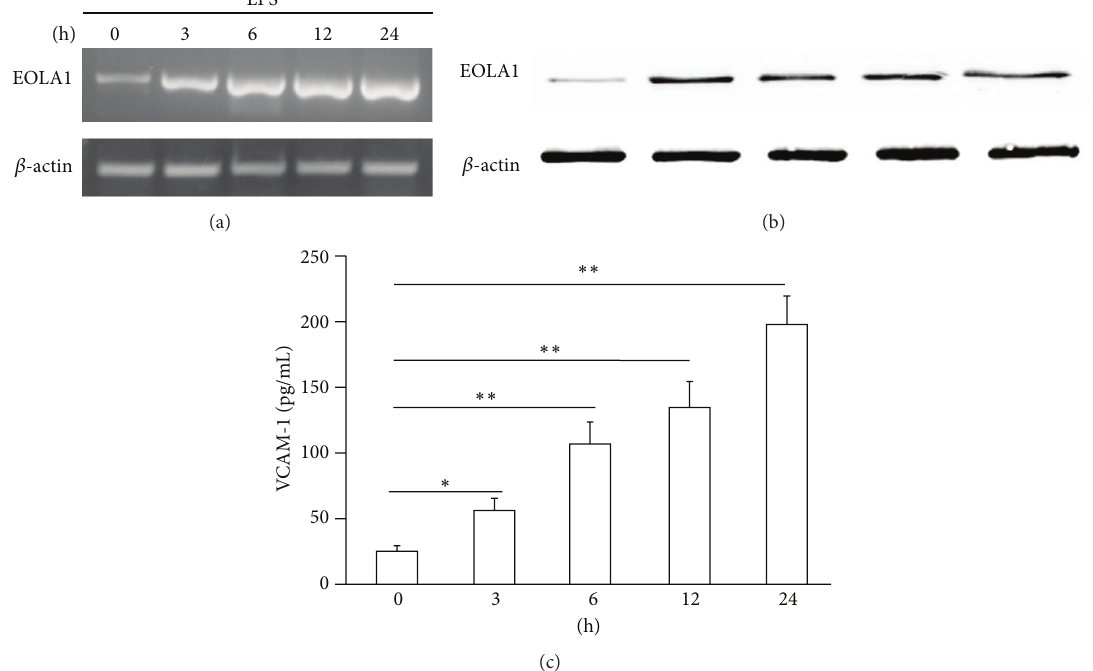
Figure 2: LPS induces the production of EOLA1 and VCAM-1 in ECV304 cells. (a) ECV304 cells were treated with LPS (100ng/mL) for various periods of time, 0, 3, 6, 12, and 24 h, and the total RNA was analyzed by RT-PCR to EOLA1. (b) The lysates of ECV304 cells were analyzed by Western blotting with antibodies to EOLA1. Data show one representative experiment out of three independent experiments. (c) ECV304 cells were stimulated with LPS (100ng/mL) for the indicated periods of time and the supernatants were collected and assayed for VCAM-1 production by ELISA. Data represent the mean ± SD of three independent experiments.